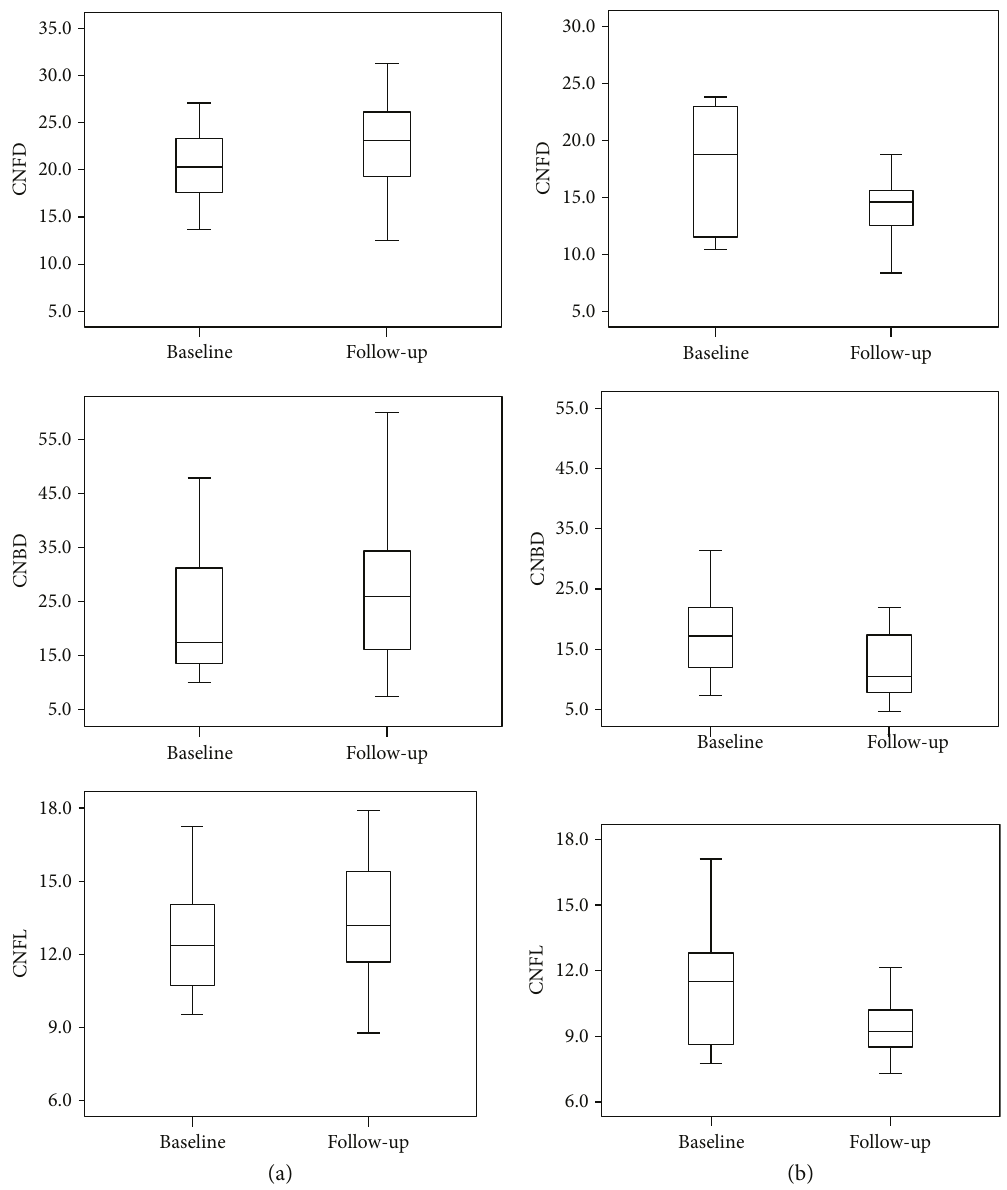
Figure 1: Changes of CCM (from top to bottom are CNFD, CNBD, and CNFL) from baseline to follow-up in group A (a) and group B